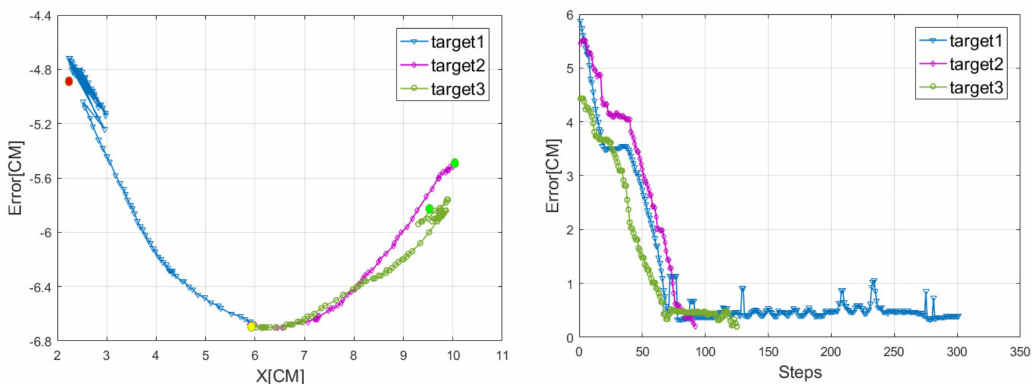
Figure 7. The End of Soft arm: Motion Trajectory and Error for Load = 1.